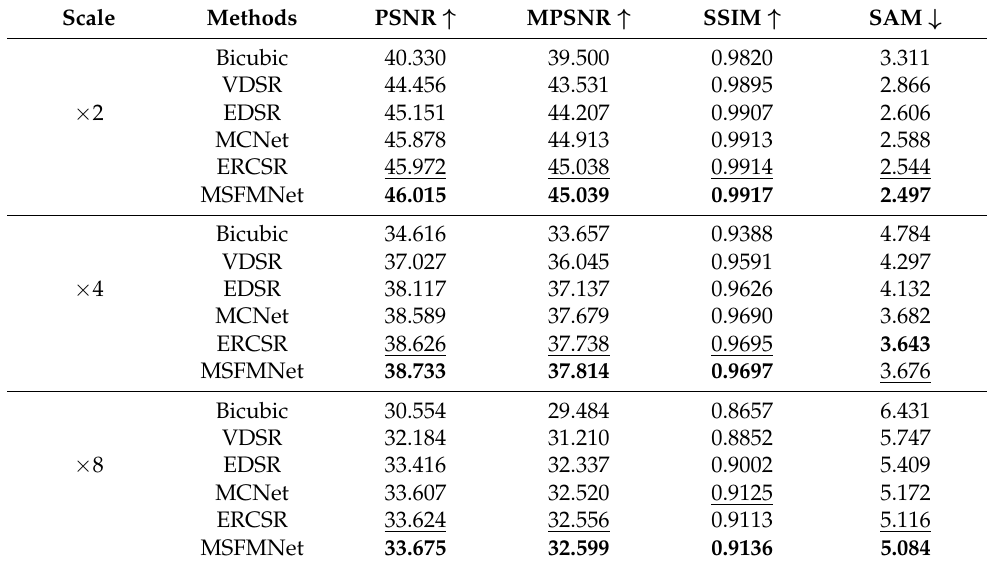
Bold values represent the best result and underlined values represent the second best.